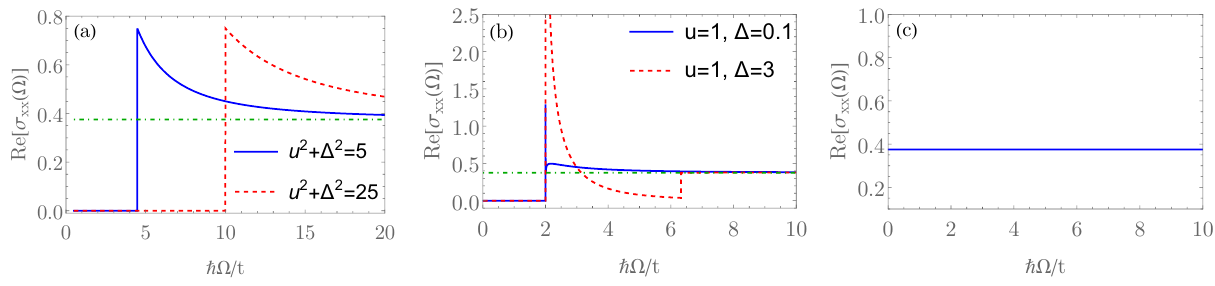
Figure 1. Real part of the optical conductivity (in units of e 2 /¯ h ) in the collisionless regime for: ( a ) the valence-bond order (VBO); ( b ) the bond-current order (BCO); ( c ) smectic charge-density wave (sCDW), respectively, given by Equations (6), (8), and (13), at the neutrality point µ = 0 and at T = 0. u and ∆ are given in units of the bandwidth scale t , see also the discussion after Equation (1). In panels ( a , b ), the green dashed line corresponds to the universal optical conductivity for the non-interacting spinless RTG in the collisionless regime, σ 0 =